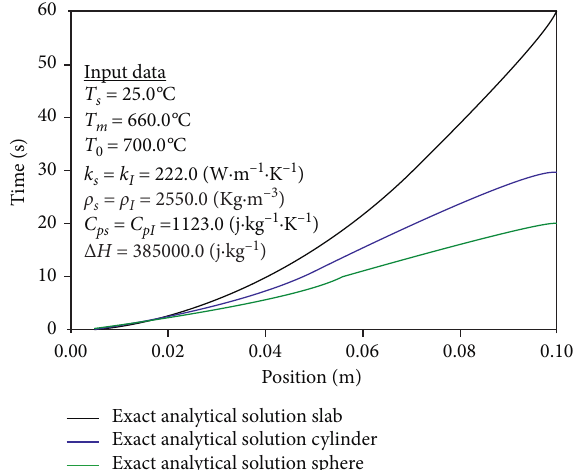
Figure 19: Comparison of concentration profiles during inward diffusion of a slab, a cylinder, and a sphere as a function of di- ) at 70% of R mensionless position ( R / R . ξ 0 0